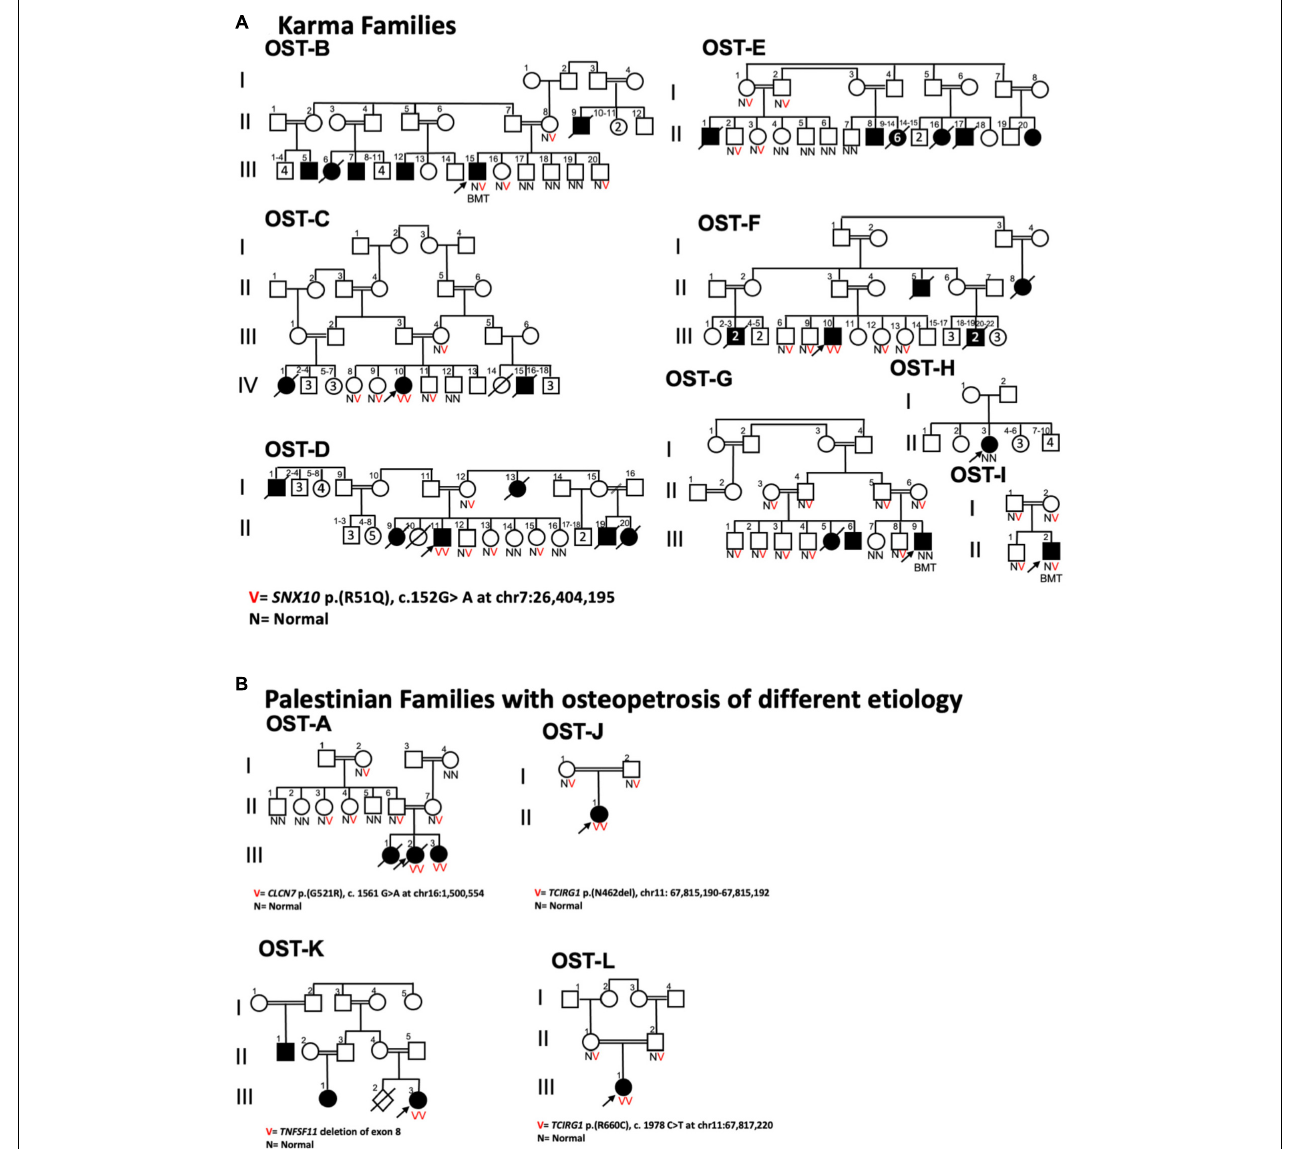
FIGURE 3 | Pedigrees of Palestinian families displaying ARO. (A) Karma village families displaying SNX10 p.R51Q genotype of sampled individuals; arrows indicate probands. Highly consanguineous marital relationships produce offspring with two copies of the mutant SNX10 allele that segregate with ARO phenotype. B/III-15, G/III-9, and I/II-2 ARO patients underwent hematopoietic stem cell transplantation, and thus their allele compositions reflect those of their unaffected donors. The only exception is the affected individual H/II-3 in OST-H Family, who was wildtype for SNX10_p.R51Q variant as discussed in the text. (B) Pedigrees of four Palestinian families from other regions of the West Bank with affected individuals diagnosed with osteopetrosis displaying different genetic mutations. The affected individual of a family from Ramallah (OST-J family) was homozygous for a frameshift mutation (p.N462del) in the TCIRG1 gene, and the affected individual from the Bethlehem family (OST-L family) was homozygous for a non-synonymous mutation (p.R660C) in the same gene. The affected individual from the family from Yatta (OST-A family) was homozygous for a missense mutation in ClCN7 gene: CLCN7 p.G521R. A second family from Ramallah (OST-K family) carries a deletion mutation of exon 8 in TNFSF11